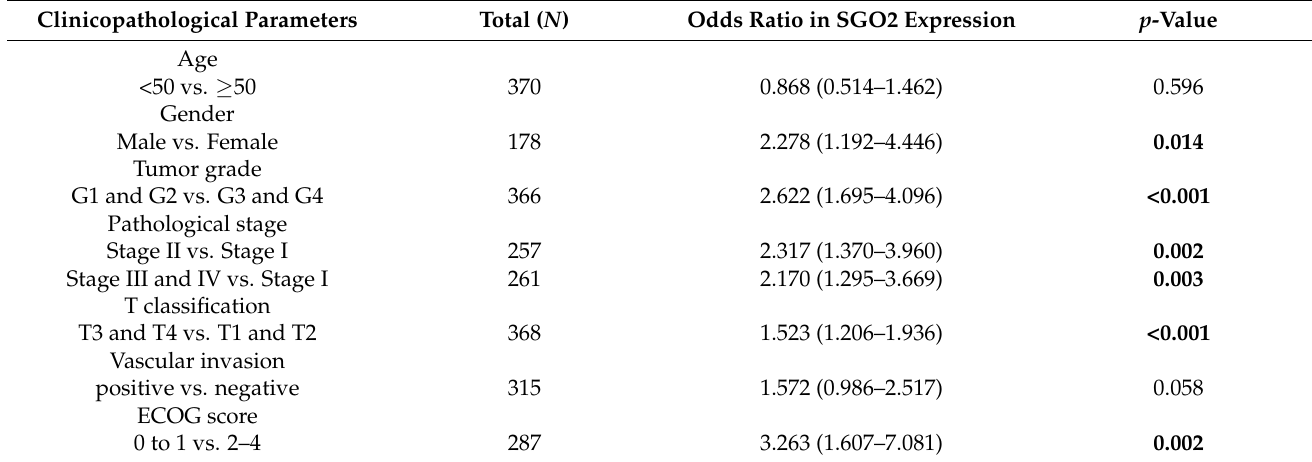
Table 3. SGO2 expression correlated with the clinicopathological